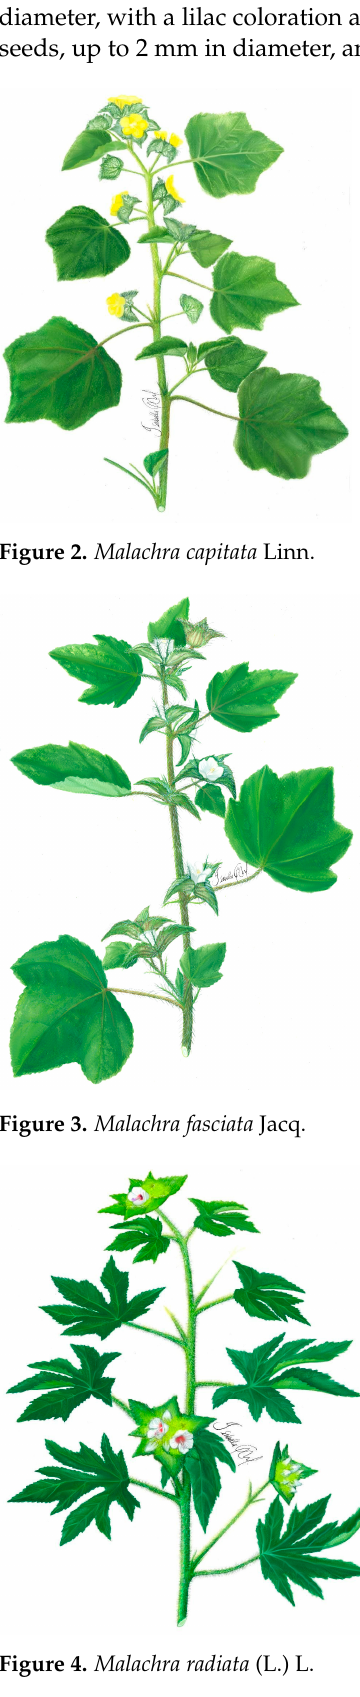
Figure 4. Malachra radiata (L.) L. Malachra ruderalis Gürke. is an annual herb, up to 3 m high, with stem pubescence and green coloration. The leaves are simple, opposite, palmate or lobed, with up to five lobes; the texture of the leaves is velvety, and their margins are crenulate; the most apical leaves have a triangular shape. It shows pedicular inflorescence with terminal or acute axillary bracts, five petals, 3 cm long, with yellow schizocarpic fruit with numerous dark- colored seeds up to 2 mm in diameter (Figure 5) [48–49].